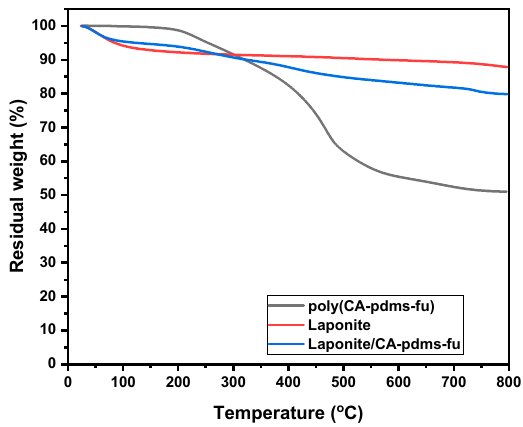
Figure 13. TGA thermograms of nanocomposite and neat polymer and laponite.